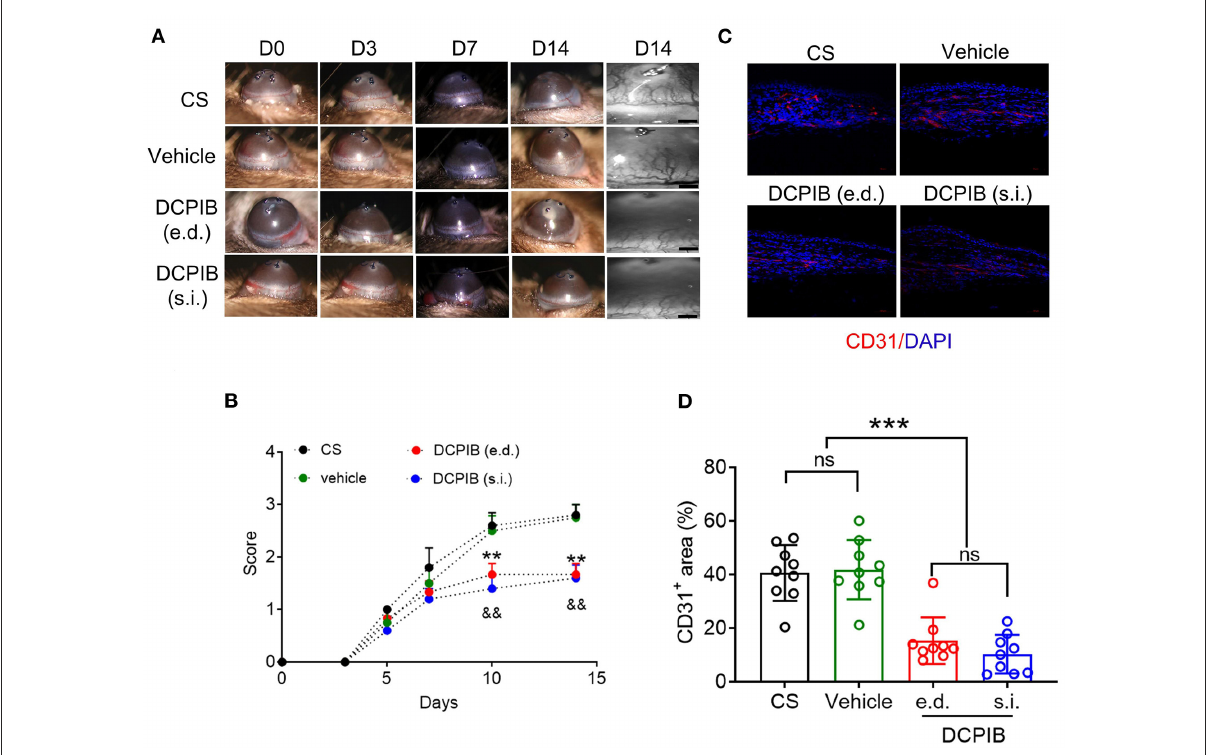
FIGURE1 DCPIB reduced mouse corneal neovascularization. (A,B) Representative slit-lamp images and semi-quantitative analysis of corneal neovascularization at days 0, 3, 5, 7, 10 and 14 after corneal suture (CS) in the presence or absence of DCPIB treatment with eye drop (e.d.) and subconjunctival injection (s.i.) ( n = 5 ∼ 6). (C,D) Representative immunofluorescence and quantitative analysis of the CD31 level in the cornea of CS mice treated with DCPIB or vehicle for 14 days ( n = 9). Red fluorescence represents CD31 and blue fluorescence represents the nuclei (stained by DAPI). Scale bar = 50 µ m. ** p < 0.01 vs. CS, && p < 0.01 vs. CS, *** p < 0.001, ns , no